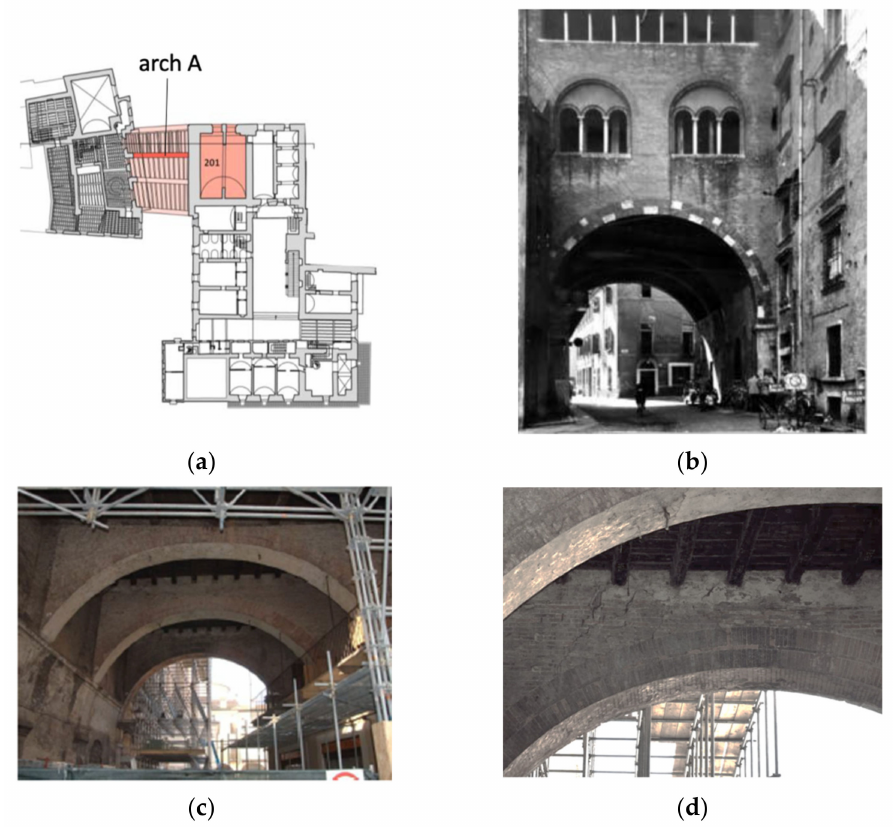
Figure 12. ( a ) Plan of the Arengario; ( b ) historical picture, taken from the Broletto square in the 1900s; ( c ) present picture of the arch system; ( d ) cracks in the arches and detail of the timber floor